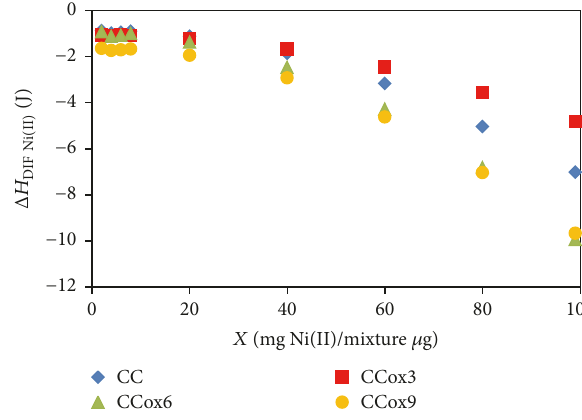
Figure 3: Immersion enthalpy of the carbonized solids in aqueous Ni(II) solutions in function of the ion mass.